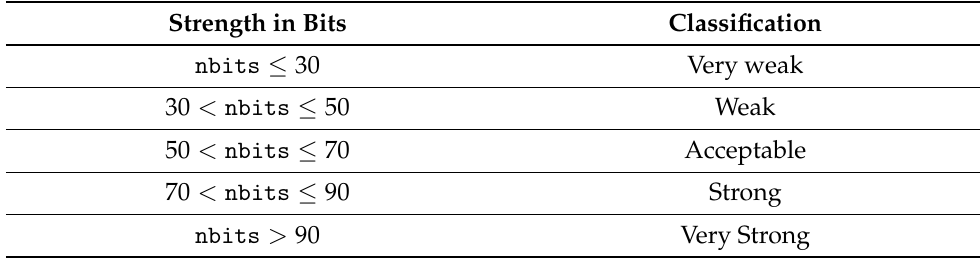
Table 3. Classification of strength of a